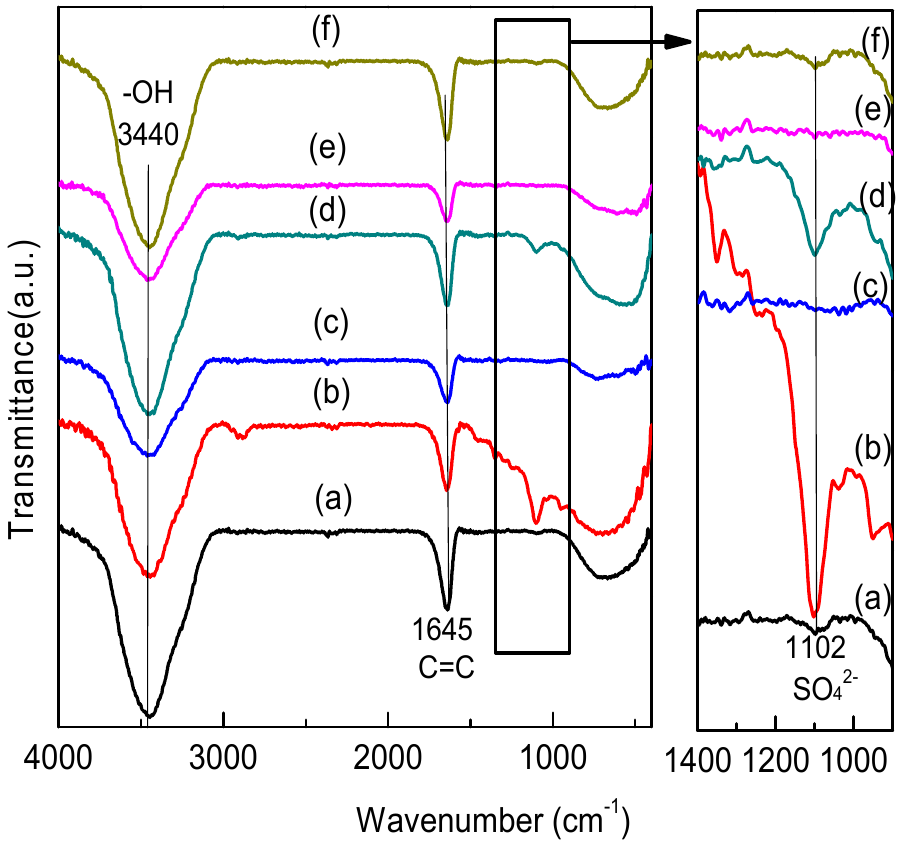
Figure 8. FTIR spectra of catalysts before and after the reaction in the presence of SO 2 . ( a ) Fresh-MnZr; ( b ) used-MnZr; ( c ) fresh-MnCeZr; ( d ) used-MnCeZr; ( e ) fresh-MnYZr; and ( f ) used-MnYZr.